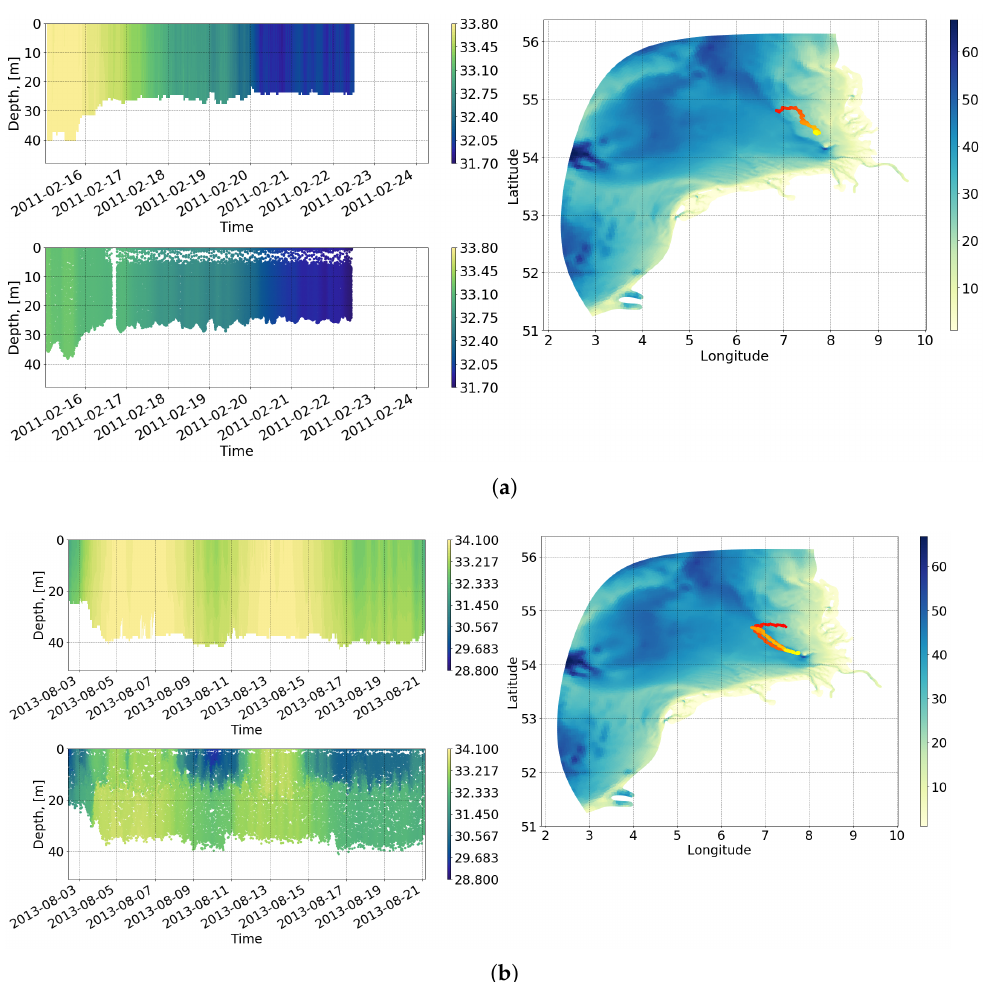
Figure 14. Comparison of model salinity with observed data from gliders: ( a ) February 2011; ( b ) August 2013. Colored circles on bathymetry maps (right) show glider paths; color indicates position times from red (beginning of the survey) to yellow (end of the survey). The filled contours at upper left are model results (21 sigma levels, 2010–2014 run). The scatter data at bottom left are from gliders (COSYNA database ([51])). The glider data time resolution is about 1 min, or 20 m horizontal resolution. The spatial resolution of the model is between 1 and 4 km.